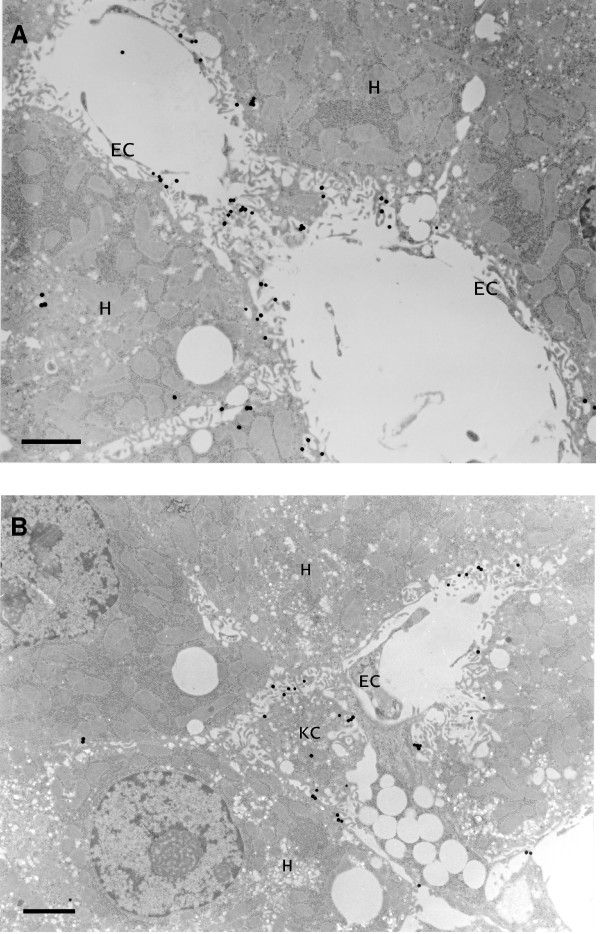
Ultrastructural localization of injected bovine LPL 125I-labeled active (upper panel) or inactive (lower panel) LPL was injected. Ten min later the rats were killed and sections of their livers were processed for autoradiography as detailed in the methods section. H, hepatocytes, EC, endothelial cell, KC, Kupffer cell. Bar: 2 μm.